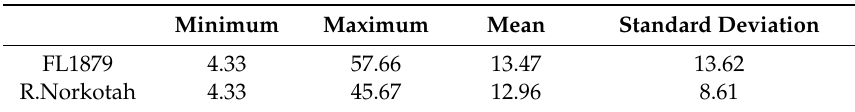
Table 1. Statistical summary of primordial leaf count (LC) measured for Frito Lay 1879 (FL.1879) and Russet Norkotah (R.Norkotah) potato cultivars.